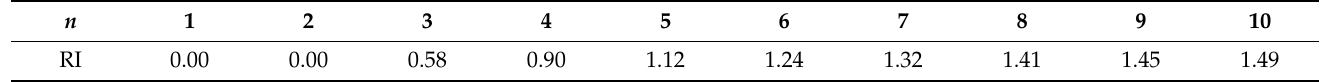
Table 4. RI values (Saaty 1980)